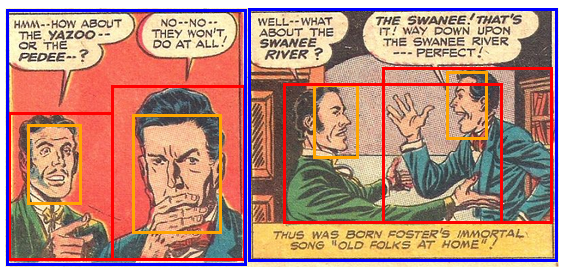
Figure 6. Examples of annotated bounding boxes for panel (blue), character (red) and face (yellow). Better viewed in